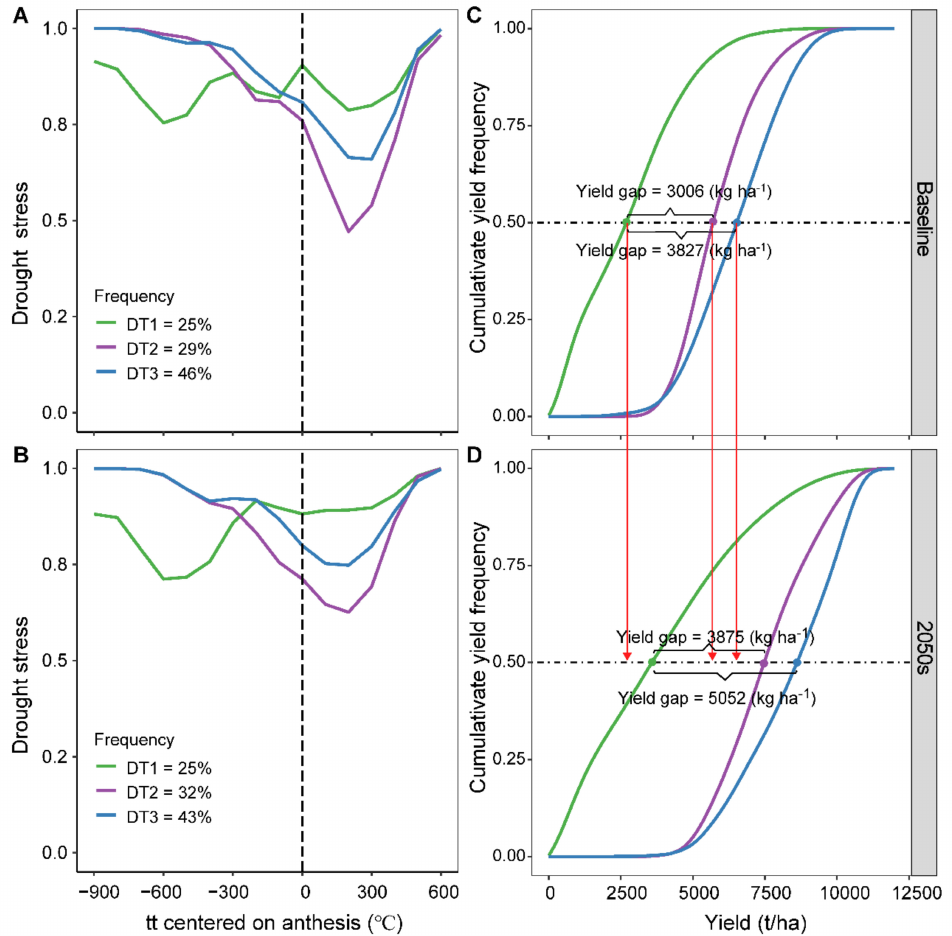
Figure 5. Crop drought-stress trajectories (1 = no stress and 0 = full stress) and trend over crop development stage expressed as thermal time (tt) before or after anthesis under historical ( A ) and future climates ( B ). (See individual site in Supplementary Figures S2–S5). Three types of drought- stress patterns (DT1: early-onset severe stress; DT2: severe stress with late recovery; DT3: moderate stress with late recovery) identified by k-means clustering. Cumulative simulated yield frequencies across all sowing dates in each drought patterns are shown for current (( C ), 1981–2010) and future (( D ), 2031–2060) climates. Points on curves indicate median yield for each drought pattern in each climate scenario. Vertical arrows are included for comparison across climate scenarios. Curly brackets indicate yield gap between different drought